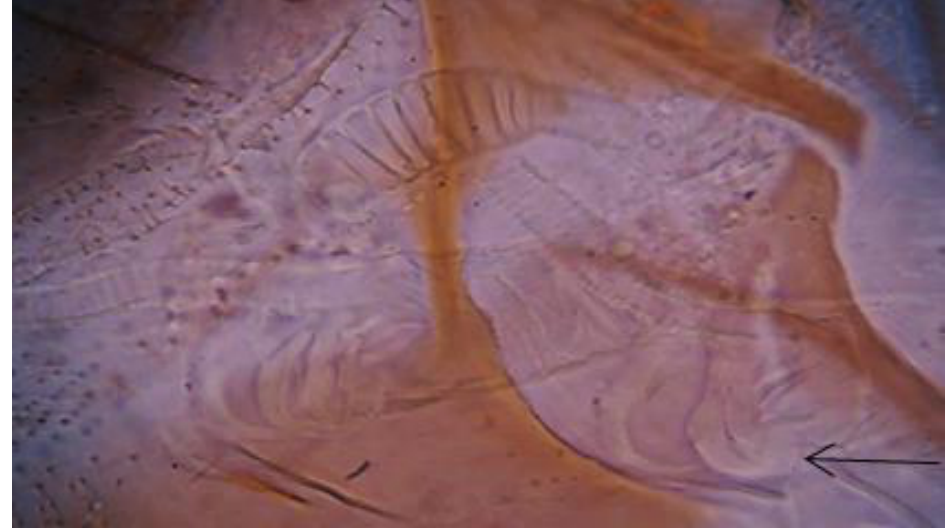
Figure 2. Photomicrograph of the genitalia ( A ) and parameral sheath ( B ) of Phlebotomus perfiliewi male.